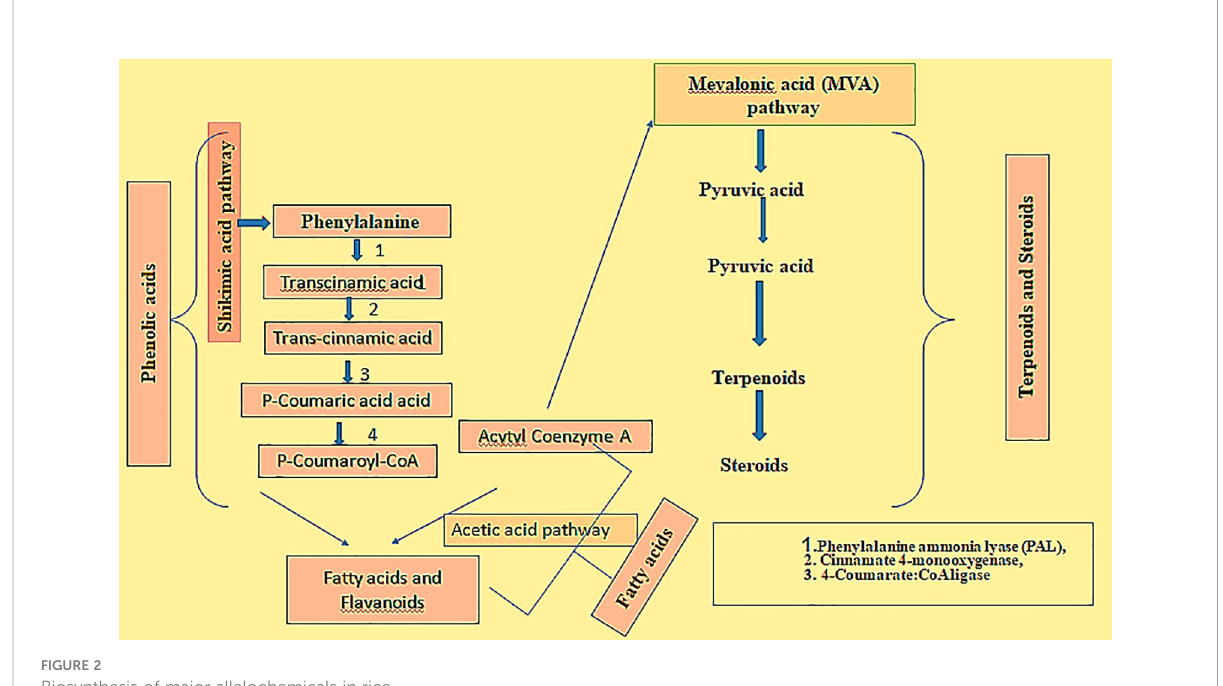
FIGURE 2 Biosynthesis of major allelochemicals in rice.